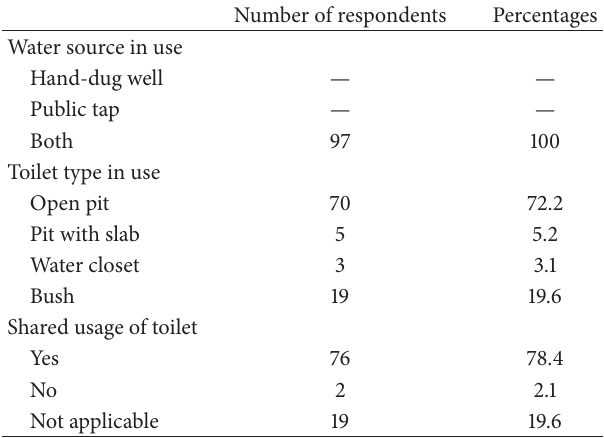
Table 9: Hygiene attitudes and practices of the surveyed preschool aged